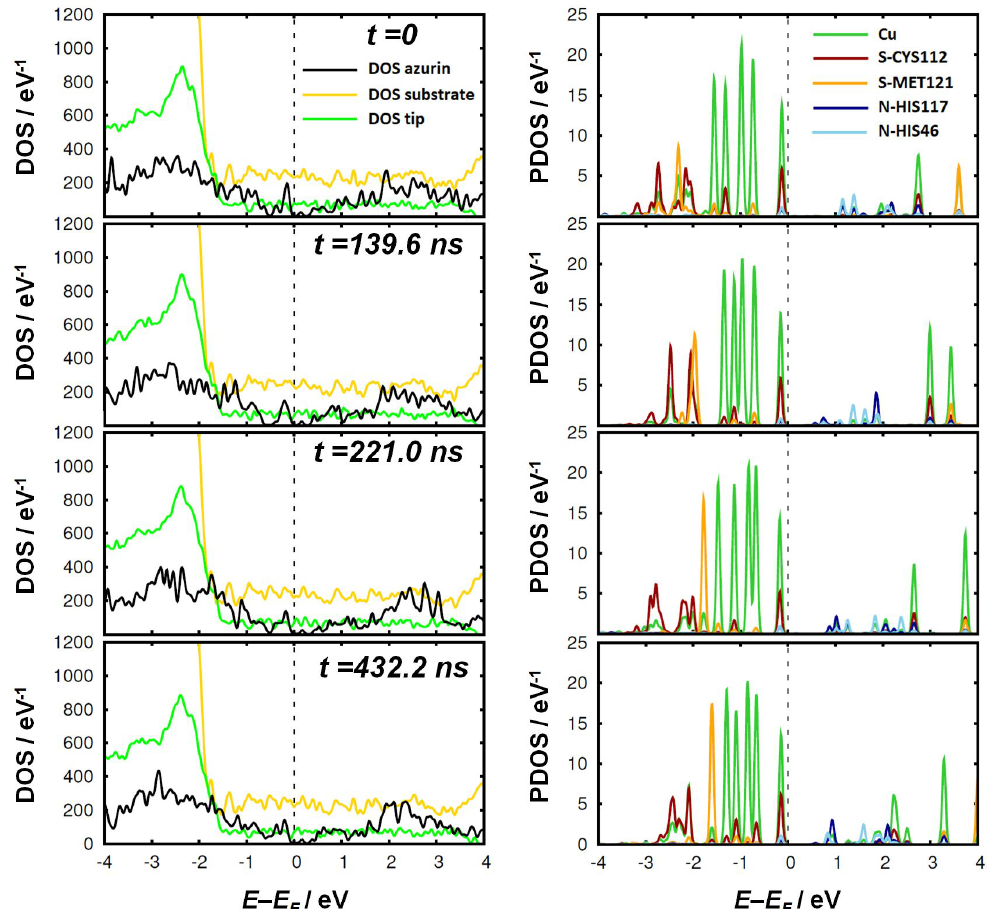
Figure 4. Density of states for relevant parts of the system at the four different time frames selected from the MD simulations. In the left panel, the PDOS of the azurin in the junction, the tip, and the substrate are given. In the right panel, the PDOS of some relevant atoms in the first coordination sphere of the Cu-center (green curve) are